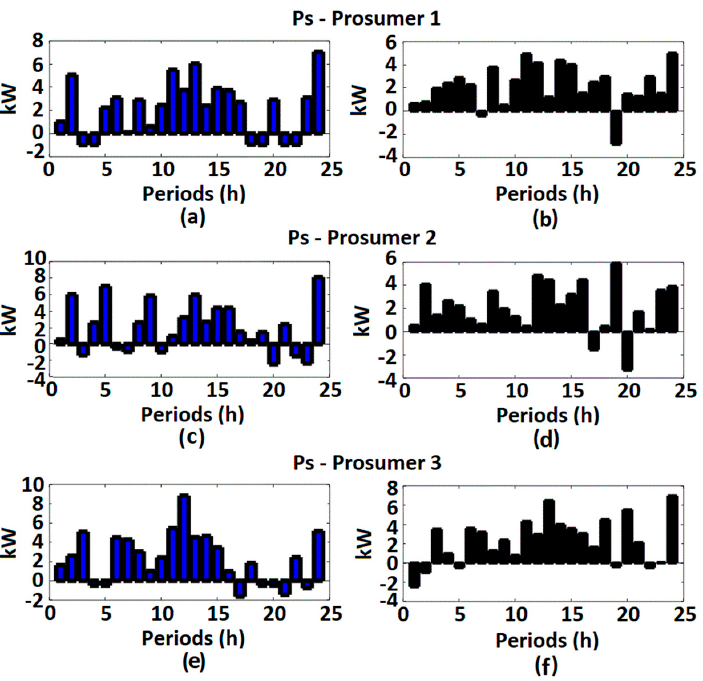
Figure 6. Bidirectional power P s measured by smart meter during the day for prosumer 1 (( a ) Case 1, and ( b ) Case 2); prosumer 2 (( c ) Case 1, and ( d ) Case 2); and prosumer 3 (( e ) Case 1, and ( f ) Case 2).